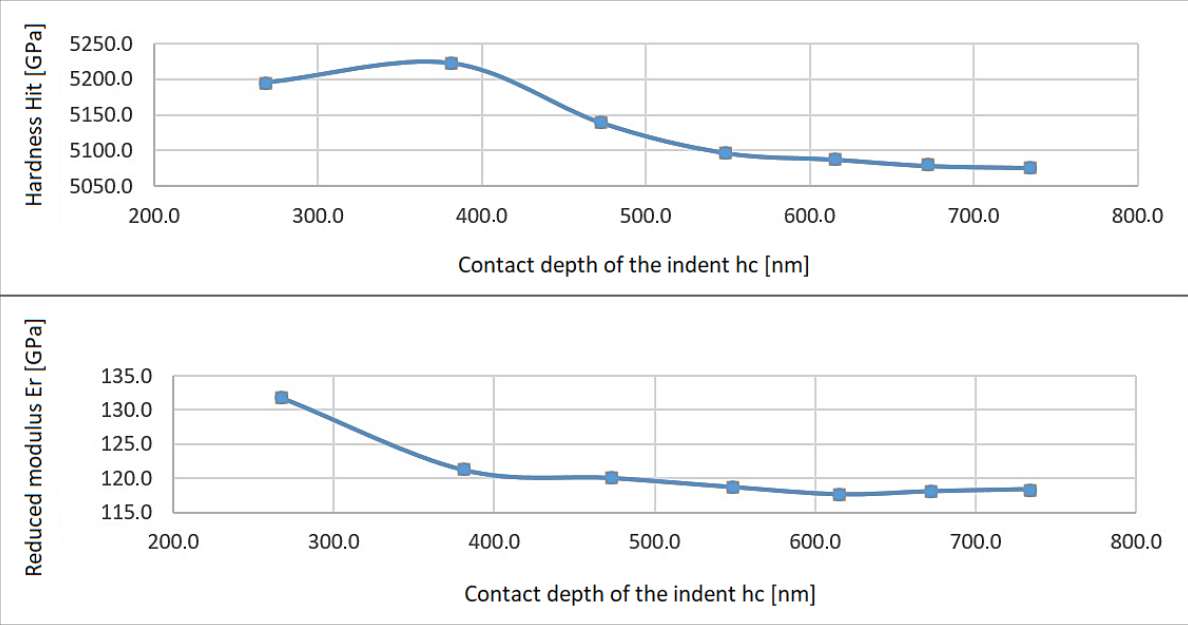
Figure 6. The trend of both measured micromechanical properties of porous specimens manufactured from a Ti-6Al-4V metal powder. The trend proved to be dependent on the depth of the